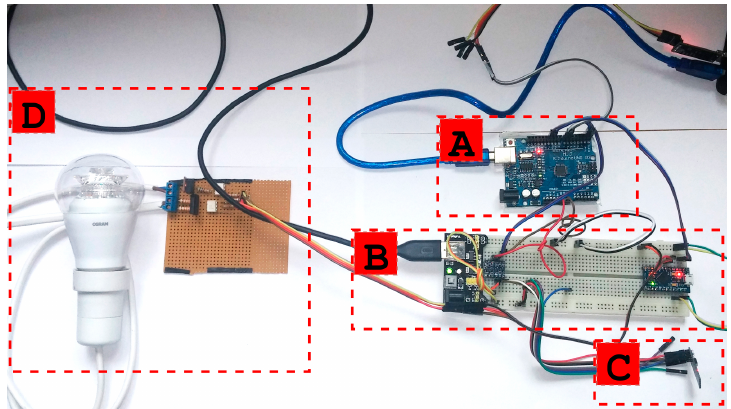
Figure 9. Example of a dimming node. ( A ) ATmega328P; ( B ) Power supply and ATmega32U4; ( C ) ESP8266; ( D ) Dulb and light regulator.